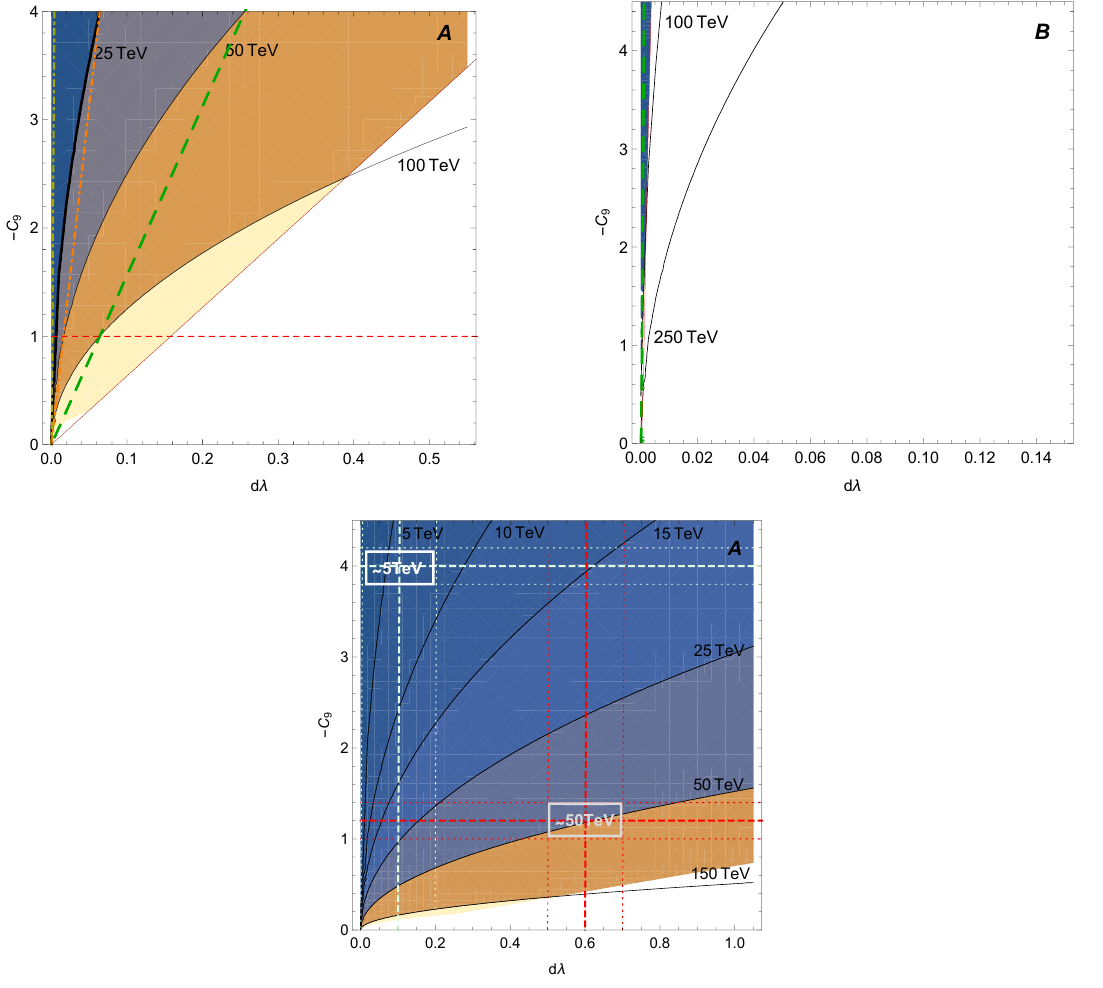
Figure 2 . Estimated (maximal) NP mass M max in dependence on the variation in the triple-Higgs self coupling ( (cid:14)(cid:21) ) and the coe(cid:14)cient of the four fermion operator O 9 ( C 9 ) in Scenario A (upper panel, left) and B (upper panel, right). The colored lines denote NP couplings of g (cid:3) = 1 ; 4 ; 8 ; 4 (cid:25) , respectively (from yellow to red). The lower panel includes two hypothetical measurements of a signal in the (cid:21) Z (cid:0) c 9 plane, setting N UV ! 1, and illustrates the correspondingly extracted masses of new particles in Scenario A . See text for